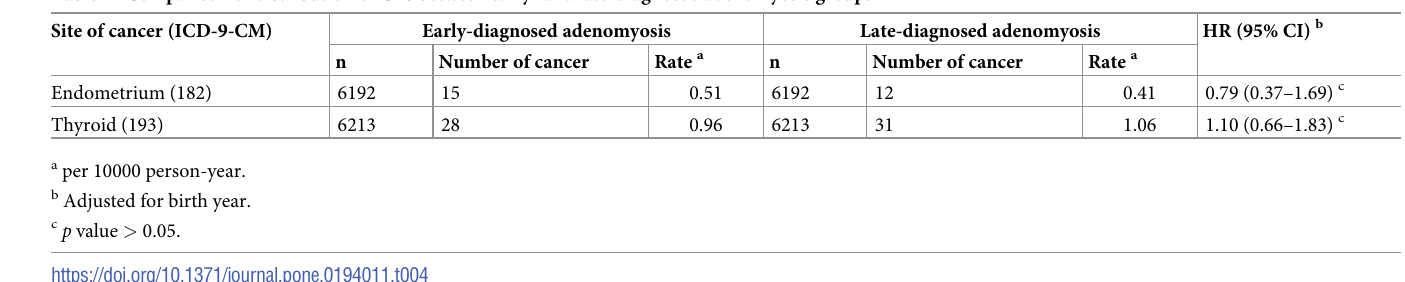
Table 4. Comparison of distribution of CFS between early- and late-diagnosed adenomyosis